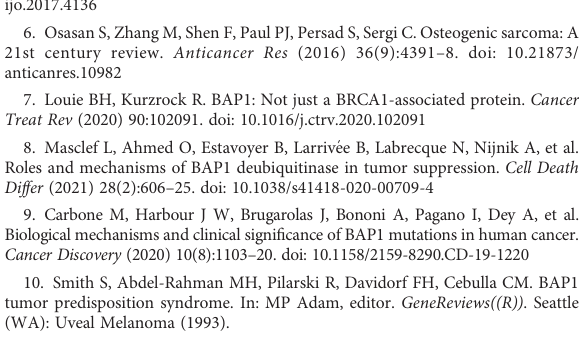
SUPPLEMENTARY FIGURE 1 The prognostic value of hub genes analyzed in osteosarcoma dataset of TARGET database. (A) The relationship of BIRC5 and overall survival. (B) The relationship of BIRC5 and progress free survival. (C) The relationship of BRCA1 and overall survival. (D) The relationship of BRCA1 and progress free survival. (E) The relationship of CCNE2 and overall survival. (F) The relationship of CCNE2 and progress free survival. (G) The relationship of CDC45 and overall survival. (H) The relationship of CDC45 and progress free survival. (I) The relationship of CDC6 and overall survival. (J) The relationship of CDC6 and progress free survival. (K) The relationship of KAT2Bandoverallsurvival. (L) TherelationshipofKAT2Bandprogressfree survival. (M) The relationship of LOX and overall survival. (N) The relationship of LOX and progress free survival. SUPPLEMENTARY FIGURE 2 The difference of GSVA score of KEGG gene sets in low and high BAP1 groups. SUPPLEMENTARY FIGURE 3 The relationship of BAP1 and immune in fi ltration in osteosarcoma dataset of TARGET database. (A) 22 types of immune cells estimated by CIBERSORT algorithm. (B) The correlation of BAP1 and StromalScore. (C) The correlation of BAP1 and ImmuneScore. (D) , The correlation of BAP1 and ESTIMATEScore. SUPPLEMENTARY TABLE 1 Sequences of shRNA Against BAP1 SUPPLEMENTARY TABLE 2 Sequences of PCR primers SUPPLEMENTARY TABLE 3 Correlation between BAP1 expression and clinicopathologic characteristics of osteosarcoma